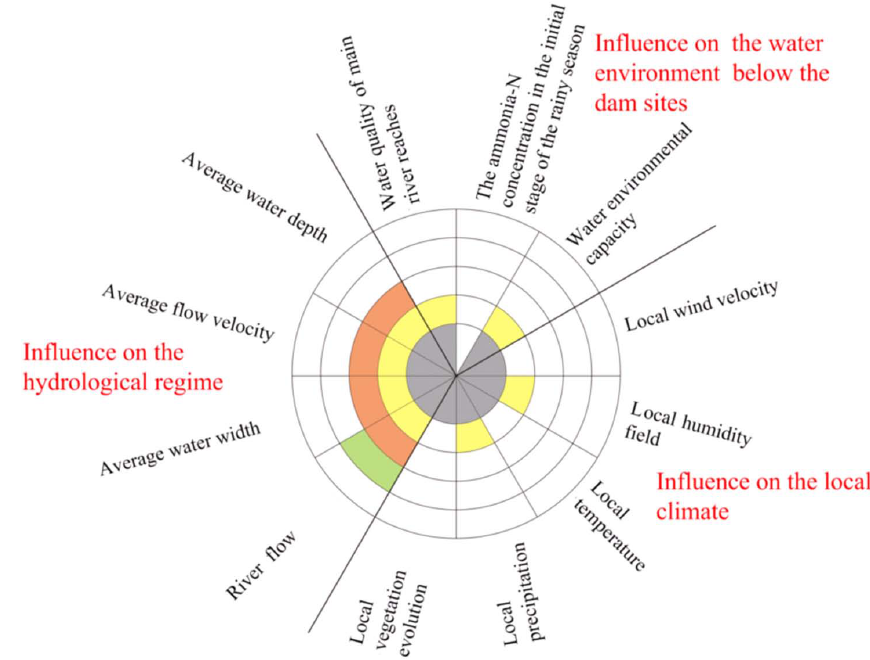
Fig. 9. Overall evaluation of the comprehensive environmental impact of the project (1).